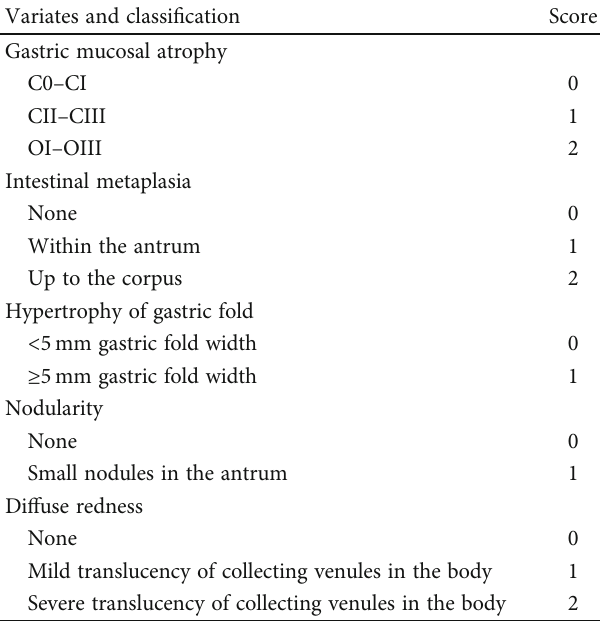
Table 2: Kyoto Classi fi cation of Gastritis scoring